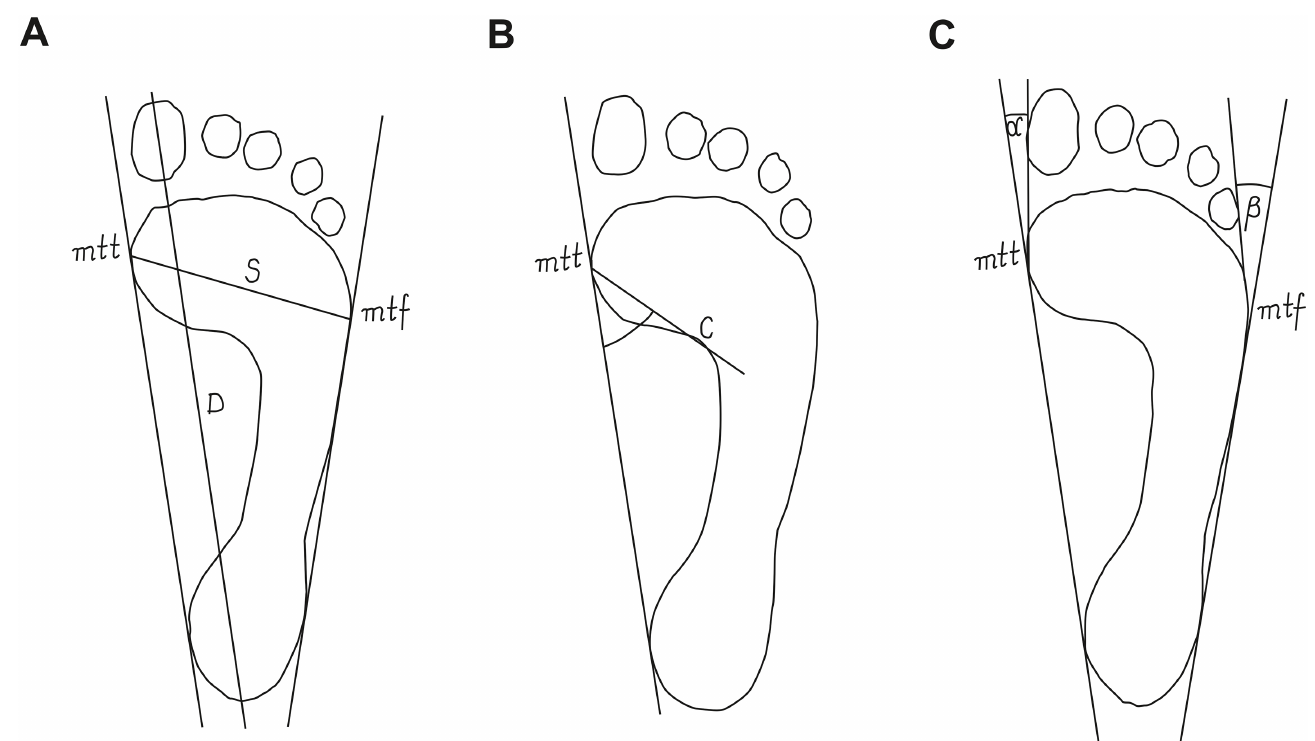
Fig 1. Procedure for determining the feet structure indices. (A) foot length, foot width and the Wejsflog index; (B) Clarke’sangle;(C) hallux valgus angle and the angle of the varus deformity of the fifth toe; mtt, metatarsaletibiale; mtf, metatarsalefibulare; D, foot length; S, foot width; C, point of the largest recess; α , hallux valgus angle, β , the angle of the varus deformity of the fifth